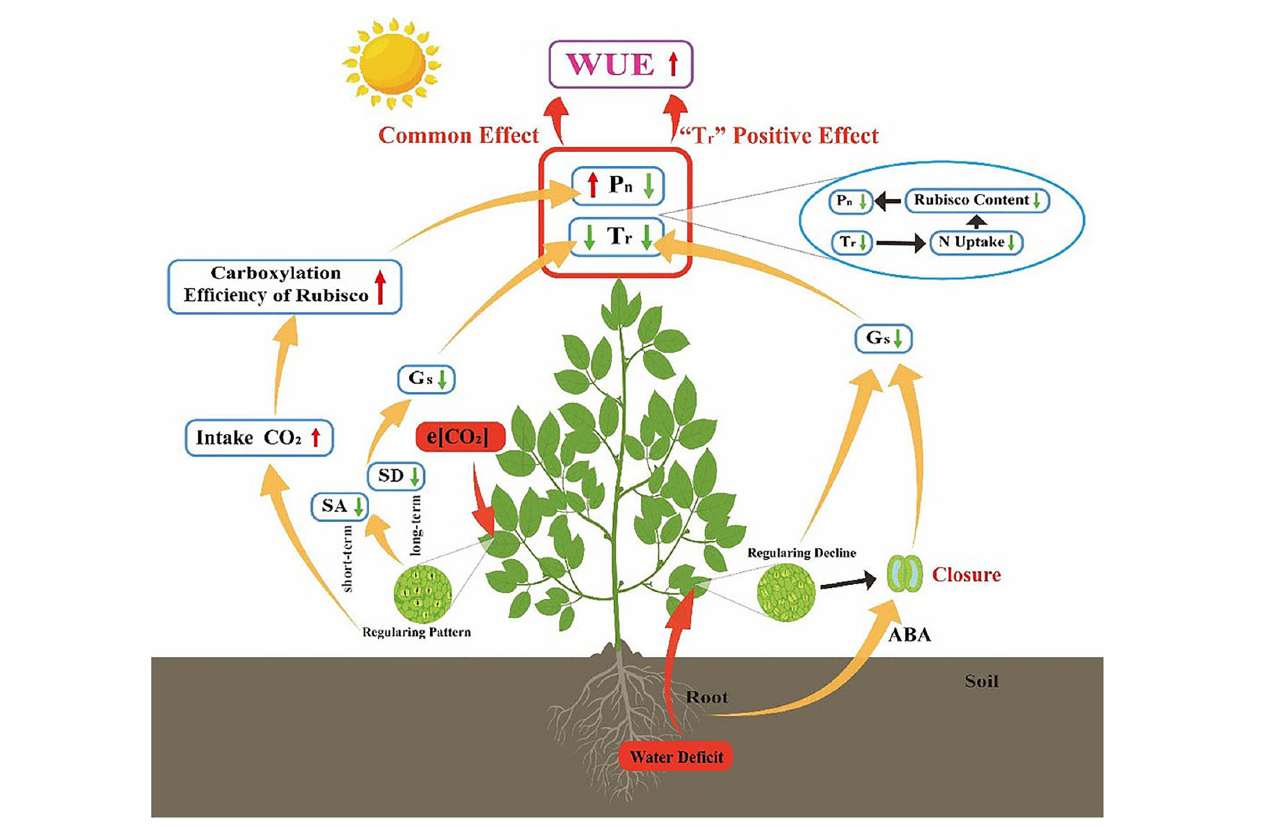
FIGURE 7 | Possible mechanism for soil water deficit constraining the CO 2 fertilization effect on gas exchange and leaf-level WUE. e[CO 2 ] increases carboxylation efficiency of Rubisco by consuming more CO 2 , which boosts P n . For short-term responses, plants reduce stomatal aperture (SA) while decreasing stomatal density (SD) for long-term response, which both can reduce G s and T r . Plant WUE is enhanced owing to the P n and T r common effect. Water stress induces abscisic acid (ABA) synthesis in the root which leads to stomatal closure and loss of regularity of stomatal distribution. Low G s and T r reduces N acquisition, thus inhibiting P n . Water deficit-induced increase of WUE is mainly caused by T r decrease rather than P n